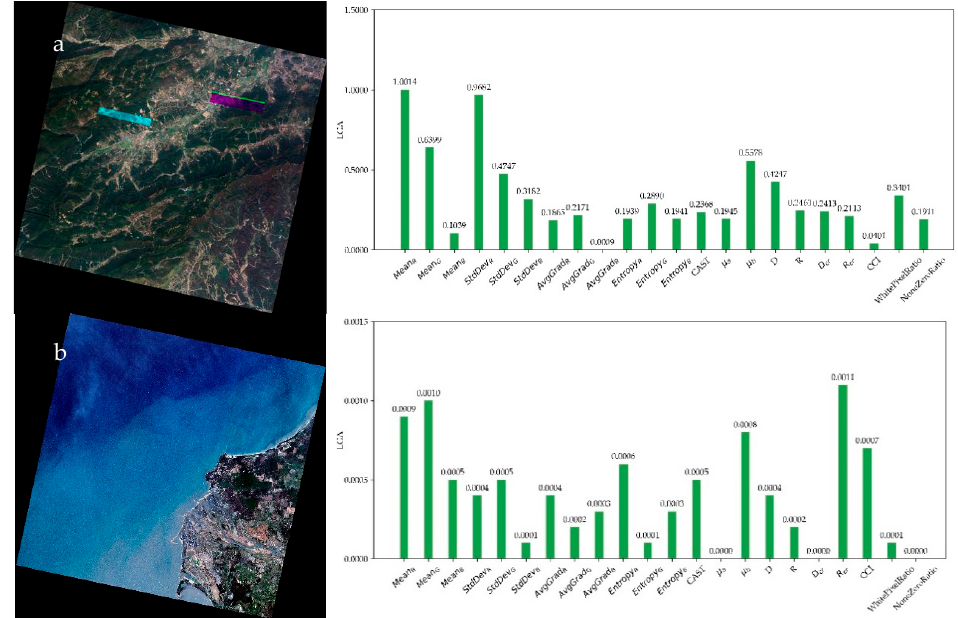
Figure 10. Examples of incorrect detection and false alarm. Best viewed in color. ( a ) is a satellite image with an abnormal colored rectangle block, but the model inferred it as normal image. ( b ) shows a satellite image of seaside with normal color, but the model inferred it as abnormal image. LGA is shown on the right.